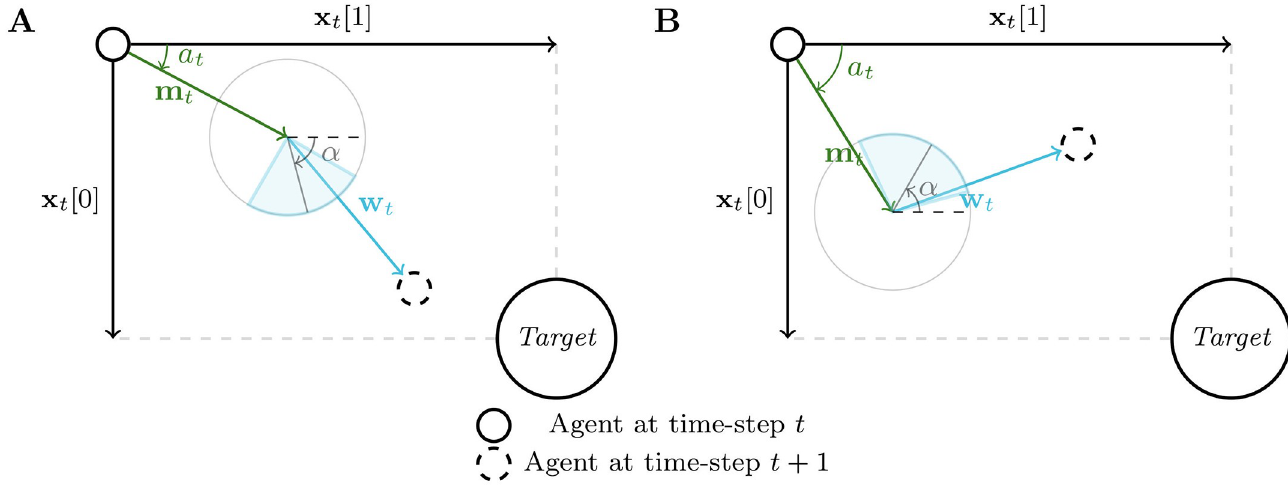
Fig 4. Sketch of a time-step interaction between an agent and two different tasks M (A and B) sampled in D for the second benchmark. Each task is defined by the main direction α of a wind cone from which a perturbation vector w m t of the agent, whose direction is given by the action a t . If the agent reaches the target, it receives a reward of 100, otherwise a reward of − 2.